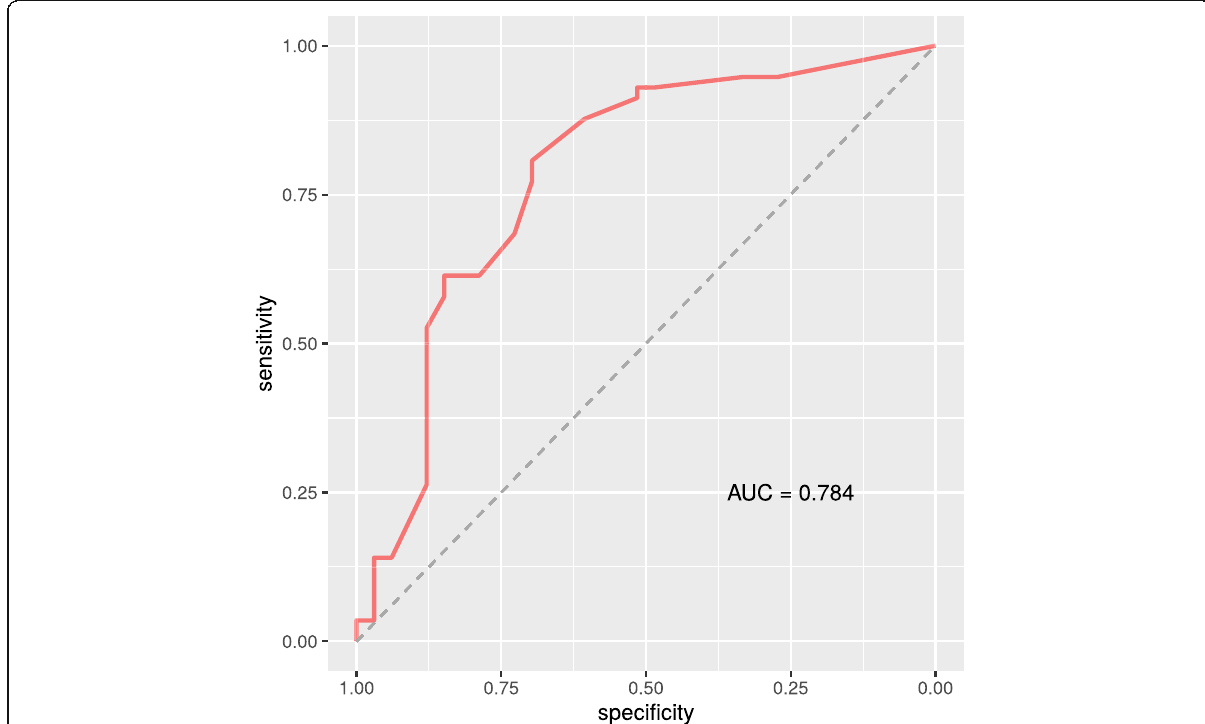
Fig. 4 ROC curve of vegetation dimension for replacement; AUC 0.78, p =